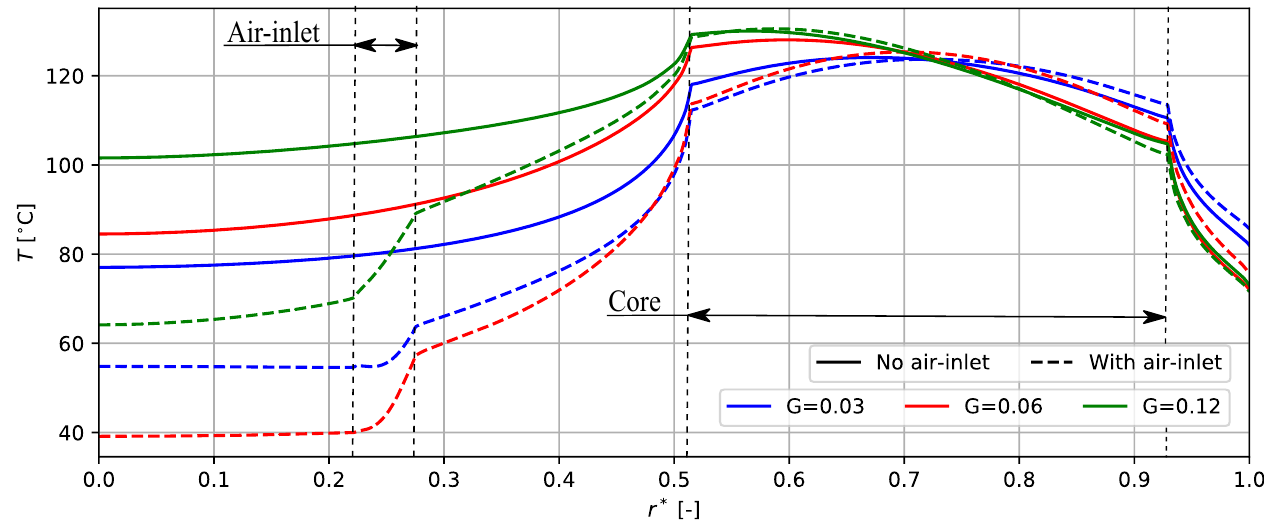
Figure 19. Temperature profile at stator wall in radial direction, r ∗ = r / R